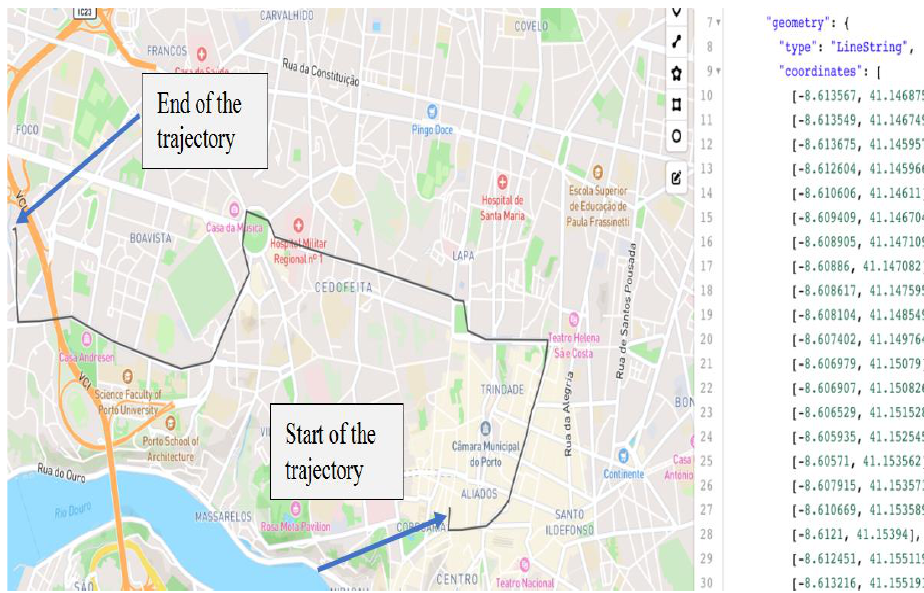
Figure 7. Example of a trajectory taken from the dataset.